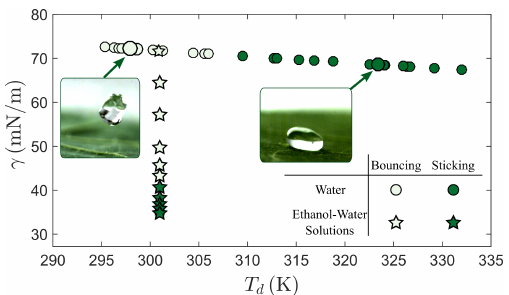
Figure 4. Effect of surface tension γ and drop temperature T d on the bouncing-sticking transition for a Nasterium leaf at ambient conditions. For water drops, the transition between bouncing (open circles) and sticking (filled circles) occurs when the drop temperature T d ≈ 307 K, which corresponds to a surface tension γ ≈ 70 mN/m. For drops of varying ethanol-water concentrations at ambient conditions, the transition between bouncing (open stars) and sticking (filled stars) occurs when the surface tension is at γ ≈ 43 mN/m. This difference in surface tension suggests that surface tension alone cannot account for the transition. Note that the larger circles correspond to the specific drop illustrated in Figure 3.